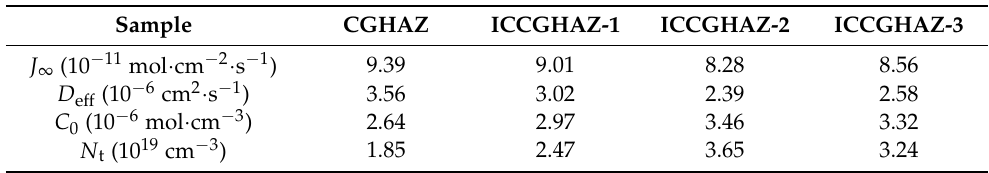
Figure 19. Hydrogen permeation curves of the CGHAZ and ICCGHAZs with different secondary peak temperatures. Table 3. Hydrogen permeation parameters of the CGHAZ and ICCGHAZs with different secondary peak temperatures.